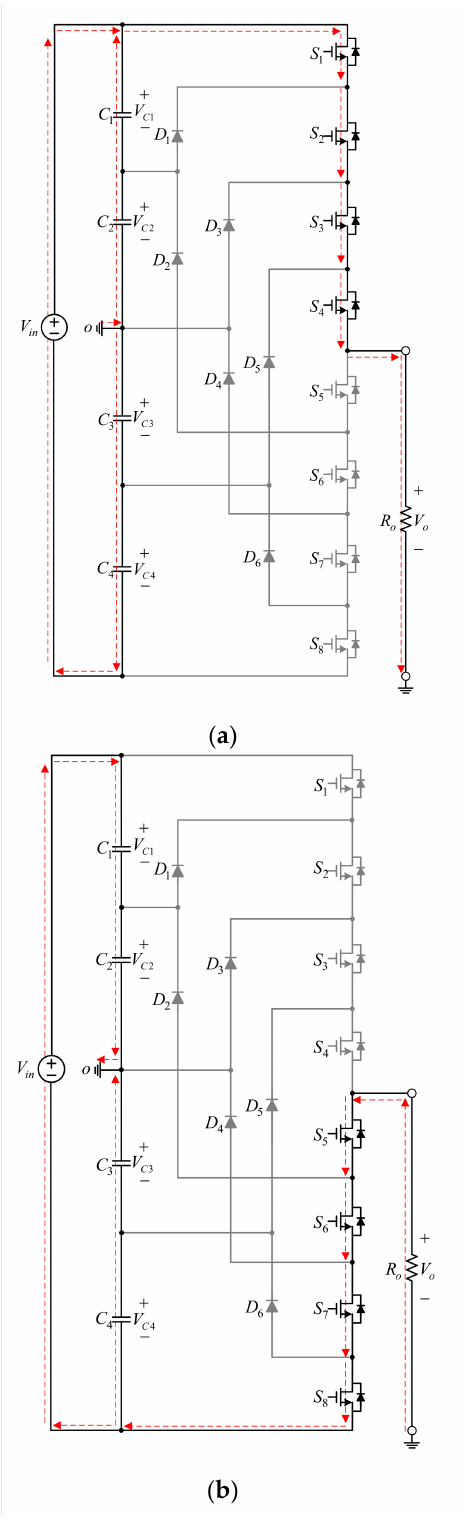
Figure 4. ( a ) Current flow direction of 0.5 V in voltage output; ( b ) current flow direction of − 0.5 V in voltage